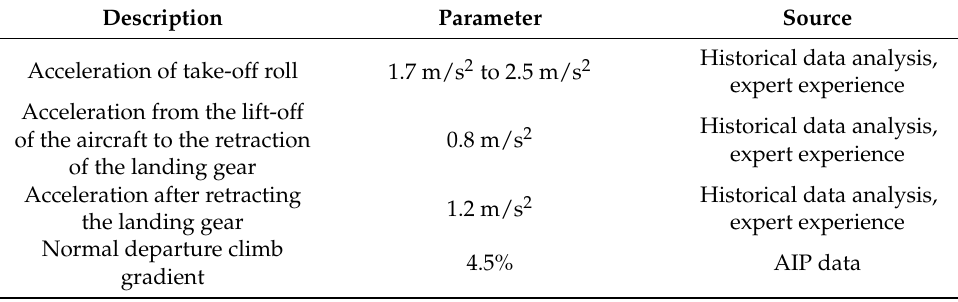
Table 1. Critical parameters of departure aircraft (A320) from runway 11L.